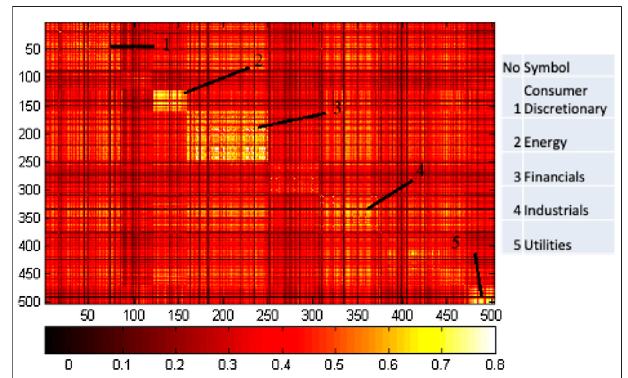
FIGURE14| Communitydetectionresultsfromthe Cg + Cm correlation matrixmappingwiththesamestockstructureasin Figure13 .Thesectorsare group 1 consumer, 2 energy, 3 fi nancials, 4 industrials, and 5